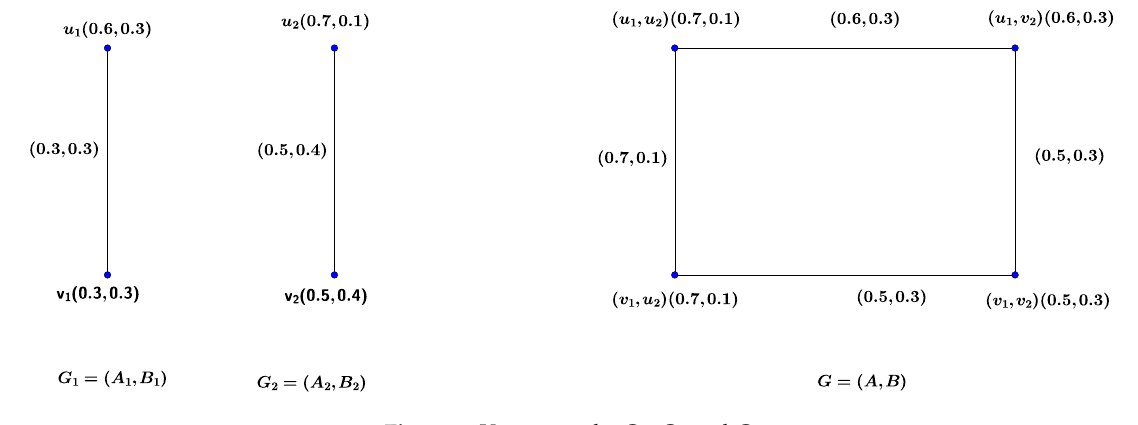
Figure 1. Vague graphs G 1 , G 2 and G